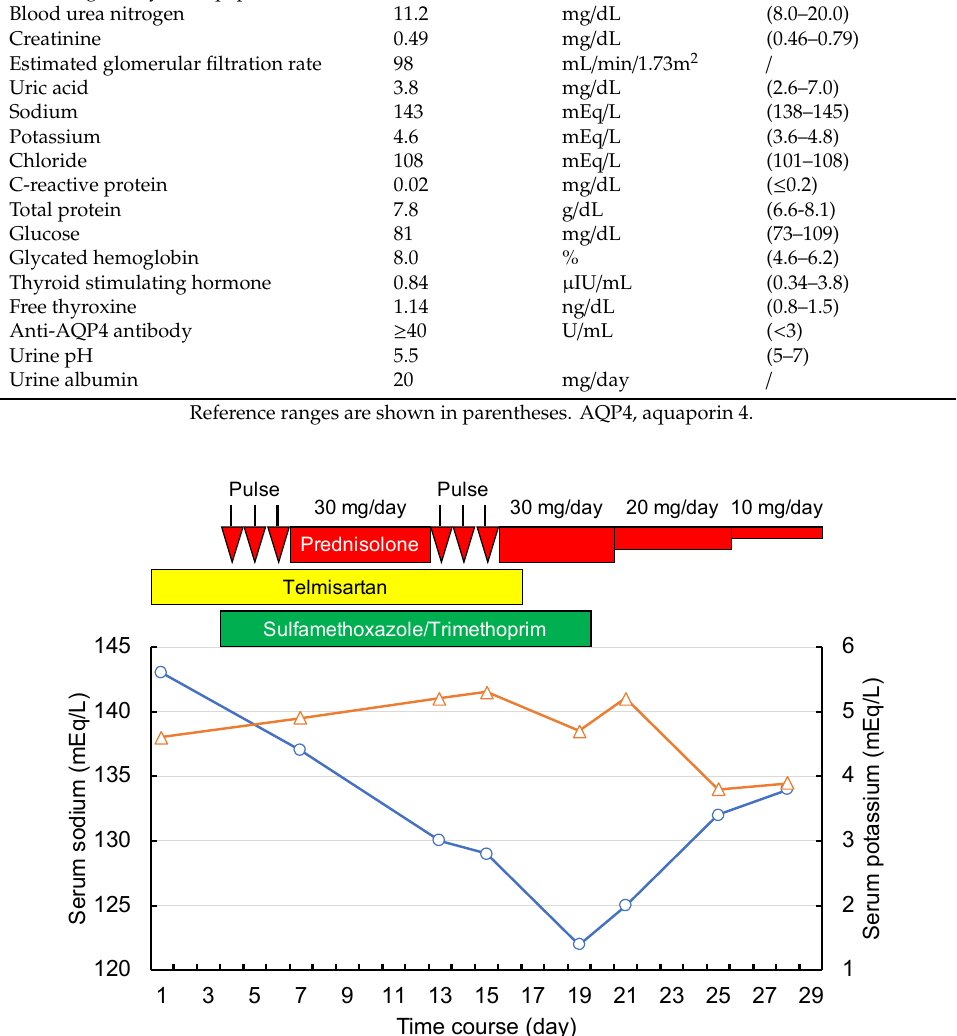
Figure 1. Clinical course. Horizontal axis indicates the time course. Vertical axes indicate electrolyte levels (blue circles and line, sodium level; orange triangles and line, potassium level). The red horizontal bar and arrows indicate steroid treatment. The yellow bar indicates telmisartan 40 mg / day. The green bar indicates trimethoprim 160 mg / day with sulfamethoxazole 800 mg /